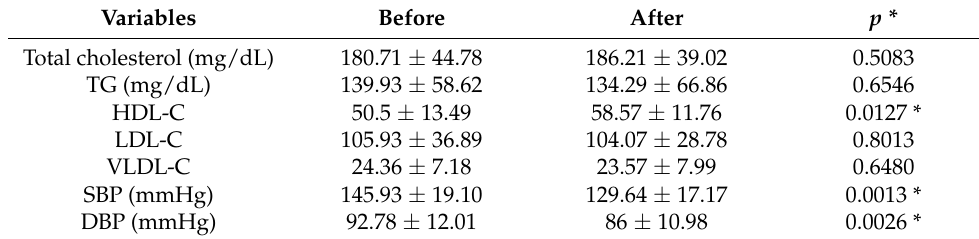
Table 2. Comparison of the blood pressures and lipid profiles of hypertensive women with excess weight, recruited from the Blood Donor Centre of Jo ã o Pessoa, PB, Brazil, before and after intervention with mixed dietary fiber.